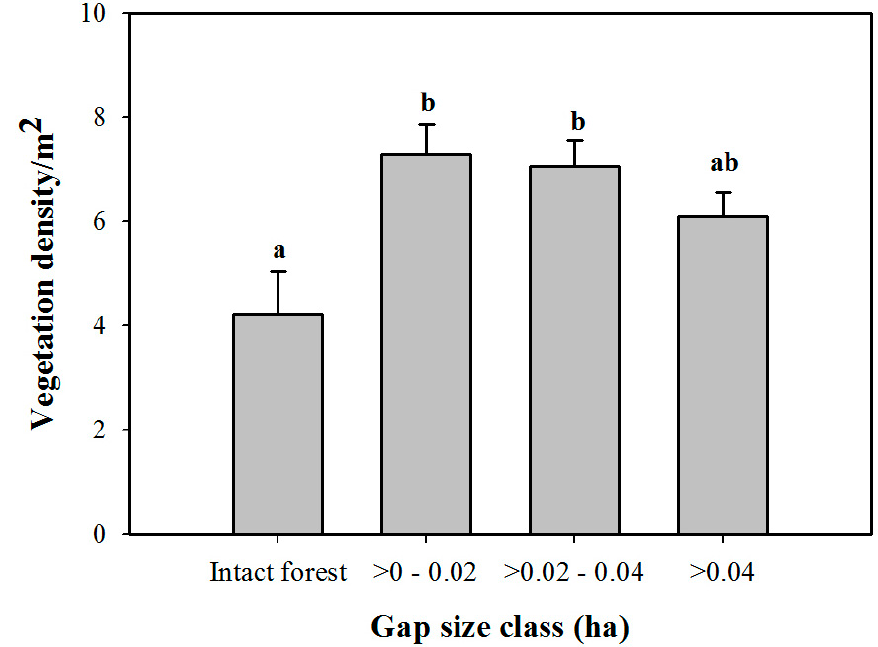
Figure 1. Understory vegetation density (stem count or clump per m 2 ) by harvest gap size (ha). Understory vegetation densities are averaged for all meter square sampling points throughout harvest gaps and intact forest plots. Error bars represent one standard error, and values with different letters are statistically different ( p ≤ 0.05; Tukey-Kramer test).